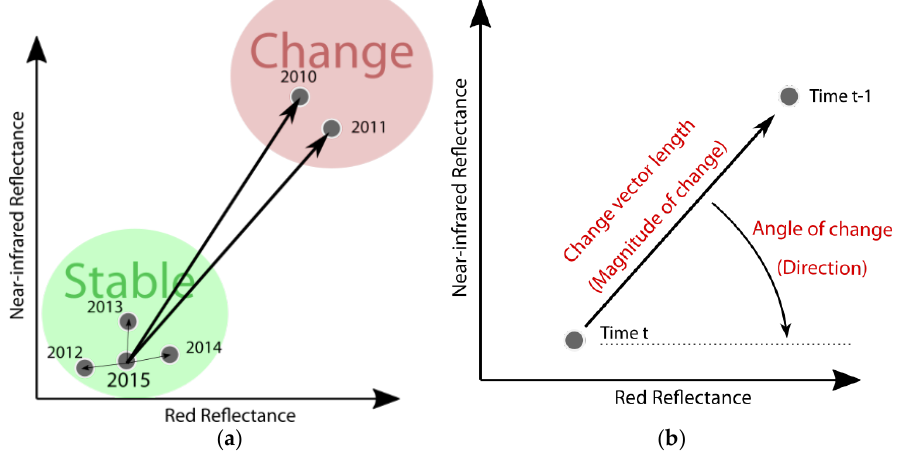
Figure 7. ( a ) left: Example of a two-dimensional change vector analysis between two timesteps using the red and near-infrared spectral bands and ( b ) right: Example of a time-series-based two-dimensional change vector analysis © GeoVille.